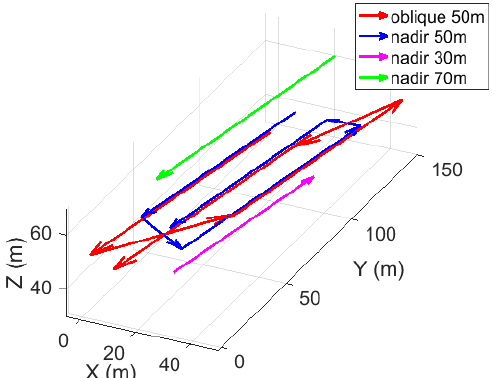
Figure 7. Flights are considered conducted in the order of legend list. The focal length increases in the direction of vectors.